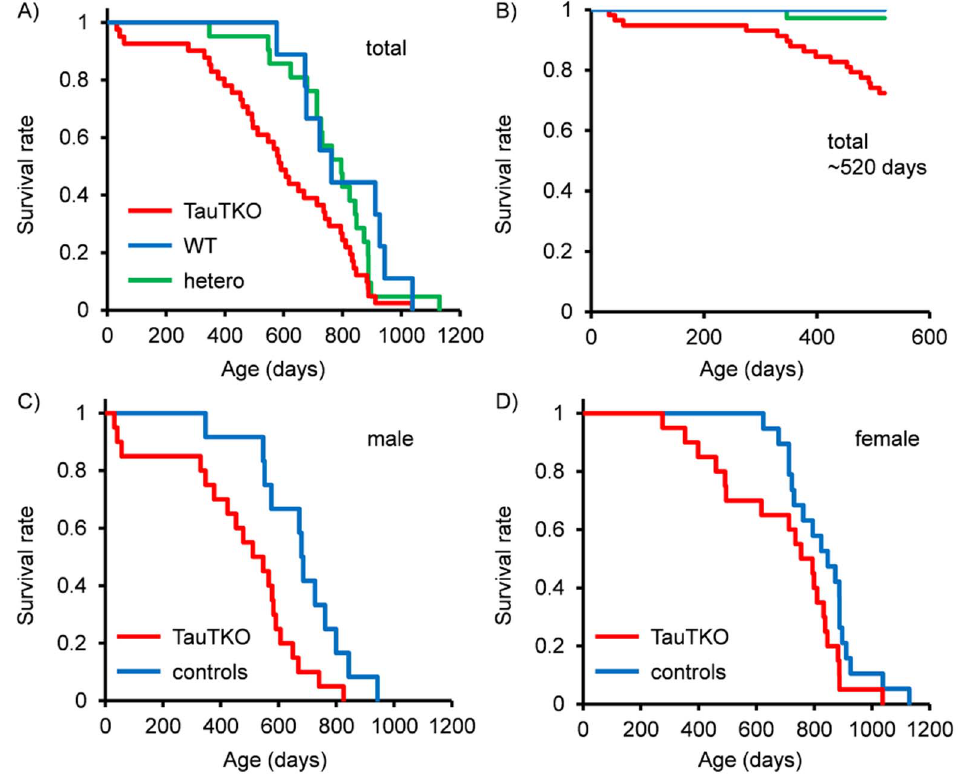
Figure 1. Shortened lifespan of TauTKO mice. Kaplan-Meier survival curves for (A,B) combined (C) male and (D) female wild-type (WT) heterozygous (hetero) and TauTKO mice. (A) n=21 (WT), 10 (hetero), 41 (TauTKO) (B) n=37 (WT), 20 (hetero), 58 (TauTKO). (C) n=12 (control; WT + hetero), 20 (TauTKO) (D) n=19 (conrol; WT + hetero), 21 (TauTKO). Data for B), but not A), C) and D), includes the mice sacrificed over 520 days after birth.